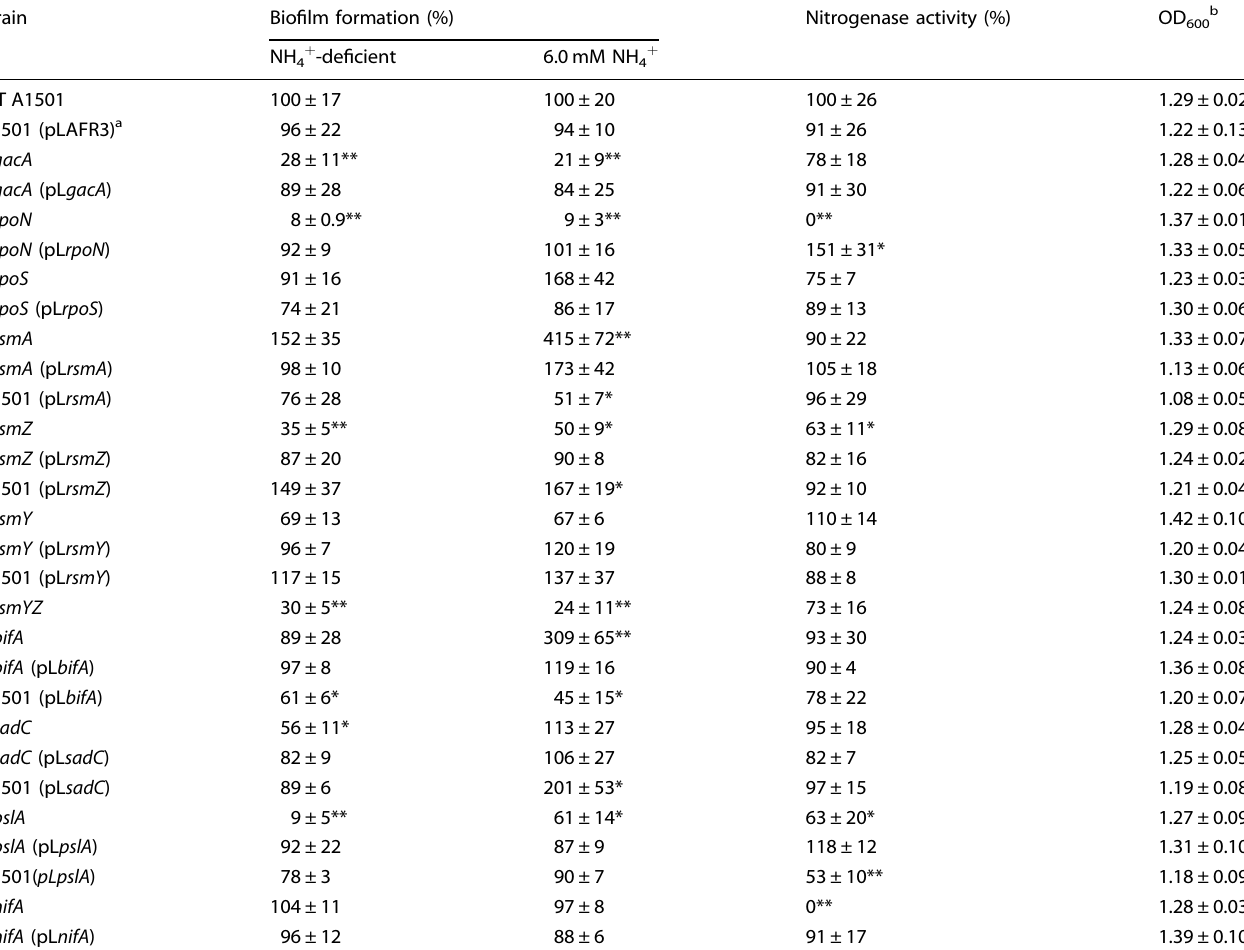
Table 1. Characteristics of the P. stutzeri A1501 mutant strains and the corresponding strains containing complementing plasmids or overexpressing the genes used in this